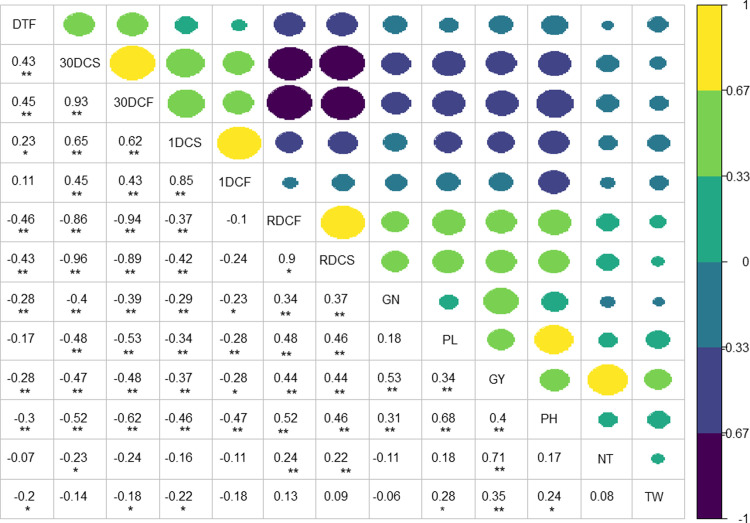
Correlation of delayed leaf senescence with agronomical traits in the BC2F4 derived population.** Correlation is significant at the 0.01 level (2-tailed); *Correlation is significant at the 0.05 level (2-tailed).